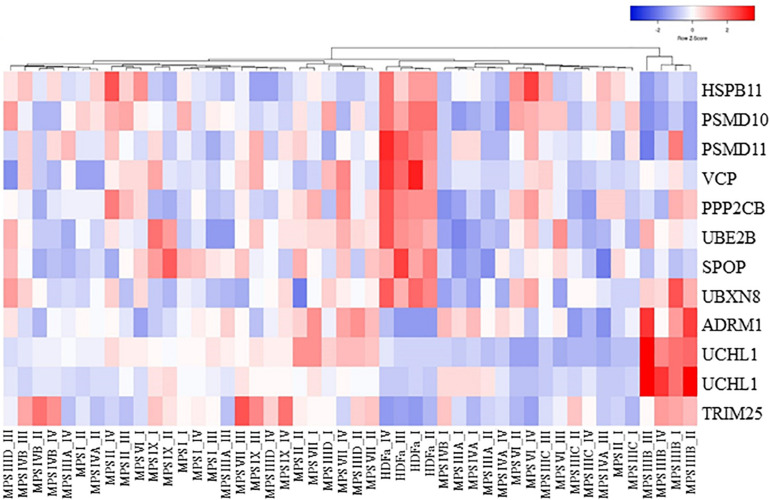
Clustered heat map of proteasome-related transcripts indicating those which levels are significantly changed in at least three MPS types/subtypes relative to the control cells. The color codes and scale are indicated.